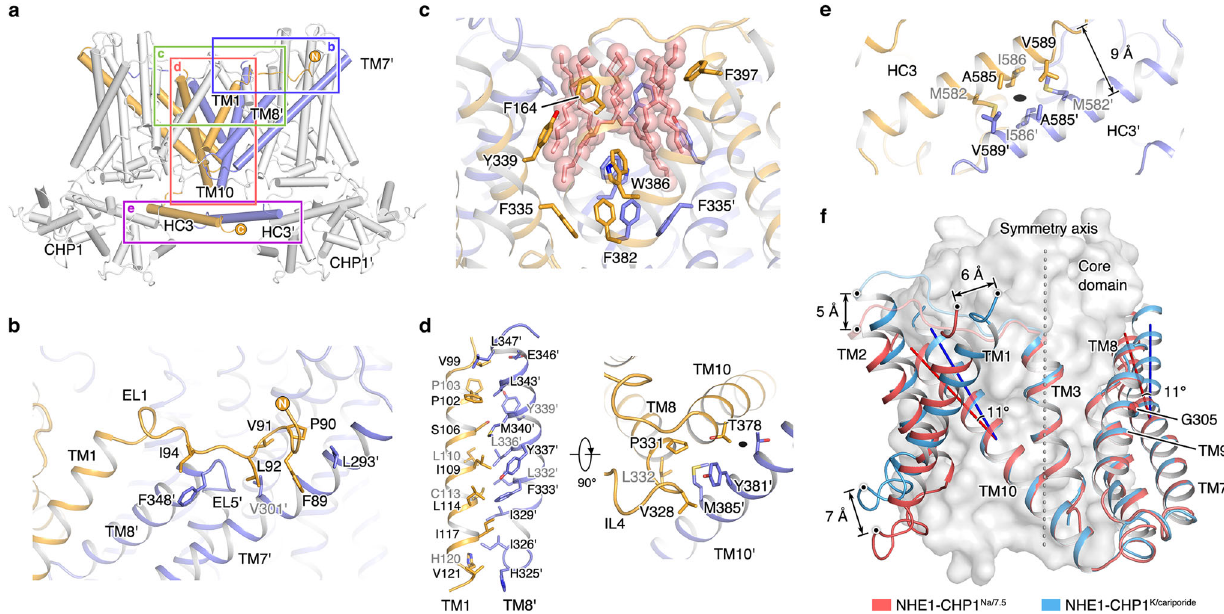
Fig. 2 Dimerization interface of the NHE1-CHP1 complex. a Helices from the dimerization domains in the NHE1-CHP1 K/cariporide complex shown in cartoon. Four regions involved in dimerization are boxed. b Interactions between EL1 and TM7 ′ or TM8 ′ in the extracellular side. Hydrophobic residues are shown as sticks. c Hydrophobic cavity between the two dimerization domains facing the extracellular side. Aromatic amino acid residues and putative lipids (salmon) within the cavity are shown as sticks. d Hydrophobic interactions between TMs 1, 8, and 10 from one protomer and TMs 8 ′ and 10 ′ from another protomer. Sidechains of residues in dimer contact are showed in sticks. The 2-fold symmetry axis is depicted as a black oval. e Dimerization of the HC3 helices around the 2-fold axis. f Structural comparison of the dimerization domain between NHE1-CHP1 K/cariporide complex (in blue) and the NHE1-CHP1 Na/ 7.5 complex (in red). The core domain is depicted as a gray surface model. The displacements of helix and helix bending are indicated. The C α atom of G305 is shown as a sphere. The 2-fold symmetric axis is depicted as a dash